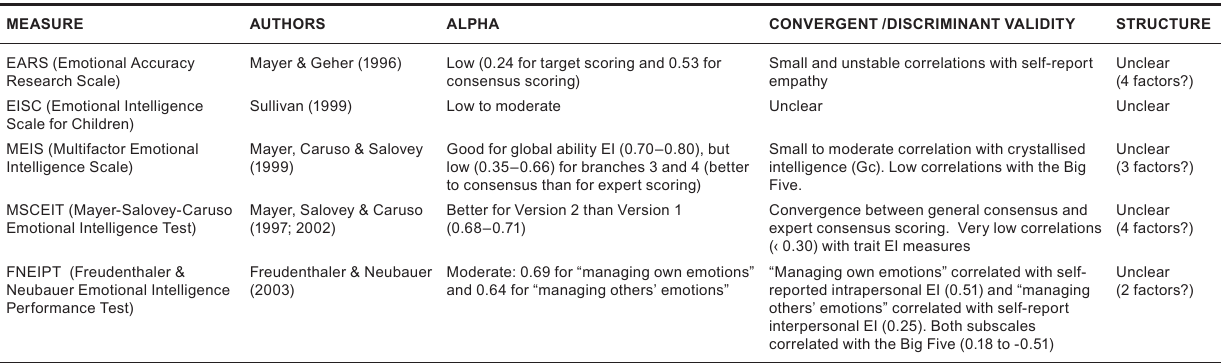
table 1 Summary of ability EI